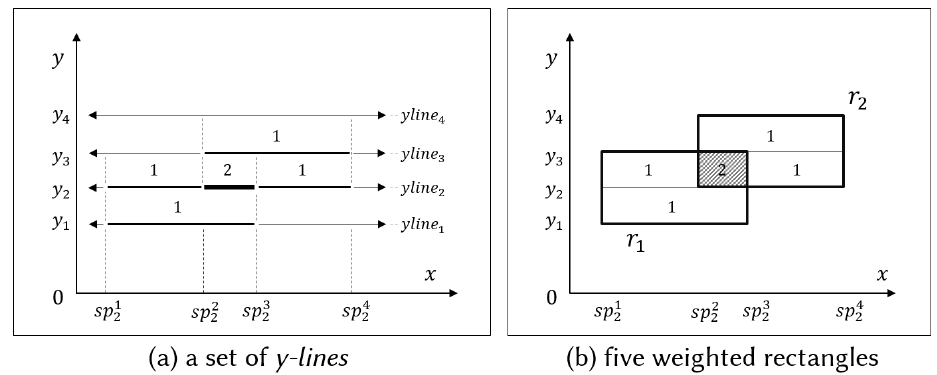
Figure 4. An example of y-lines